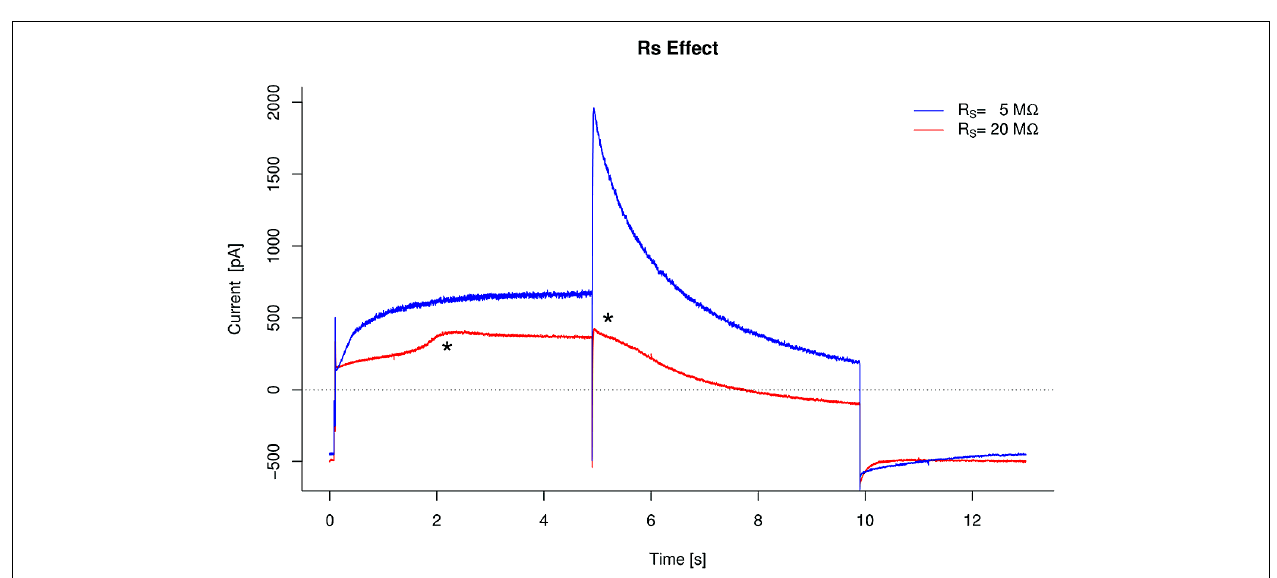
FIGURE 4 | Effect of small membrane resistance (Rm). Two superimposed hERG recordings from a cell with instable membrane resistance are shown. The blue trace represents an early recording from this cell, where Rm has a high value in the G (cid:2) range.The red trace was recorded from the same cell after Rm dropped to ∼ 100 M (cid:2) .The baseline (or “leak”) currents recorded during the brief − 50 mV “baseline step” are indicated by horizontal dotted